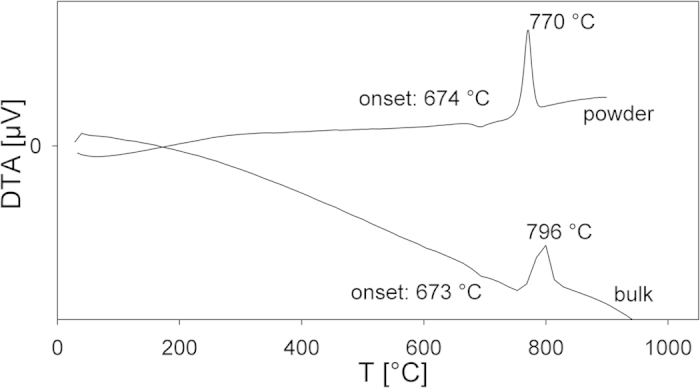
DTA measurements of the bulk and powdered 2BaO · TiO2 · 2.75GeO2 glass.The error in the temperatures evaluated from the DTA profiles is ±3 °C.